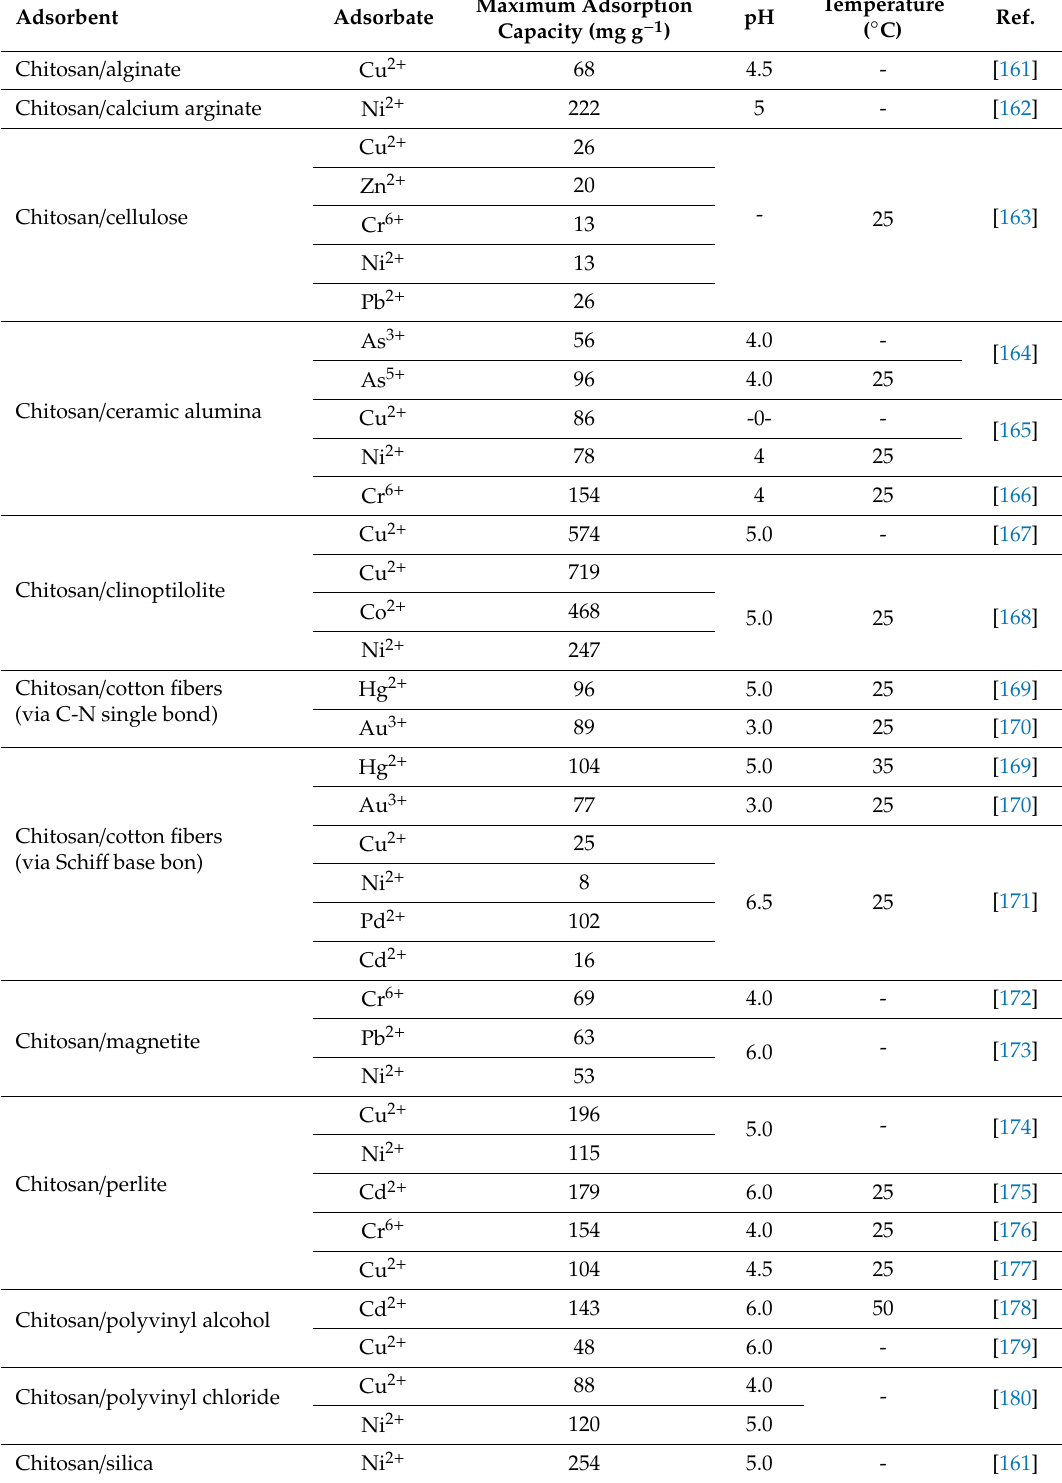
Table 10. Chitosan-based composites used in the adsorption of